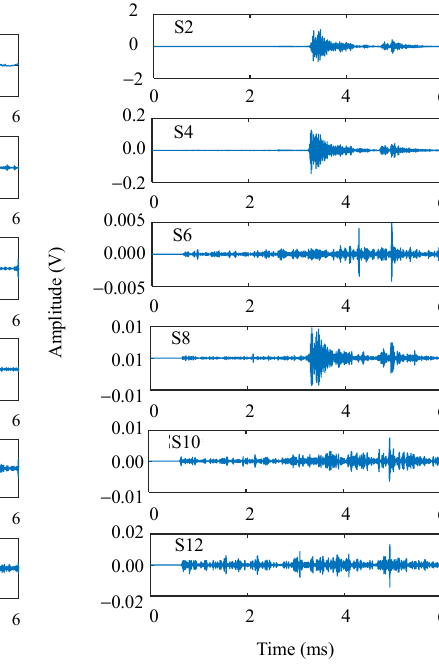
Fig. 6 Decomposition signals.